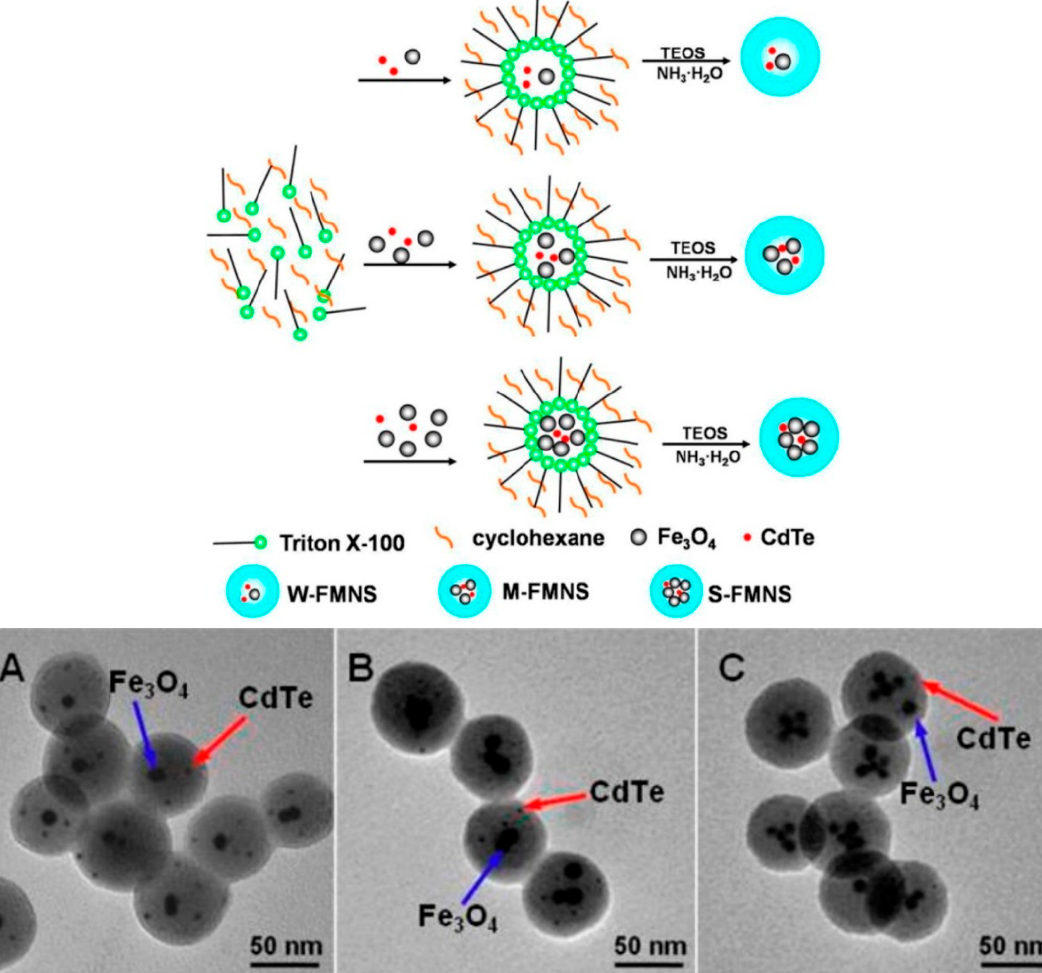
Figure 2. Schematic of Fabrication of (CdTe/Fe 3 O 4 )@SiO 2 FMNS with Different Magnetic Potentials and TEM images of (CdTe/Fe 3 O 4 )@SiO 2 FMNS: ( A ) W-FMNS, ( B ) M-FMNS, and ( C ) S-FMNS. Adapted from ref. [29].